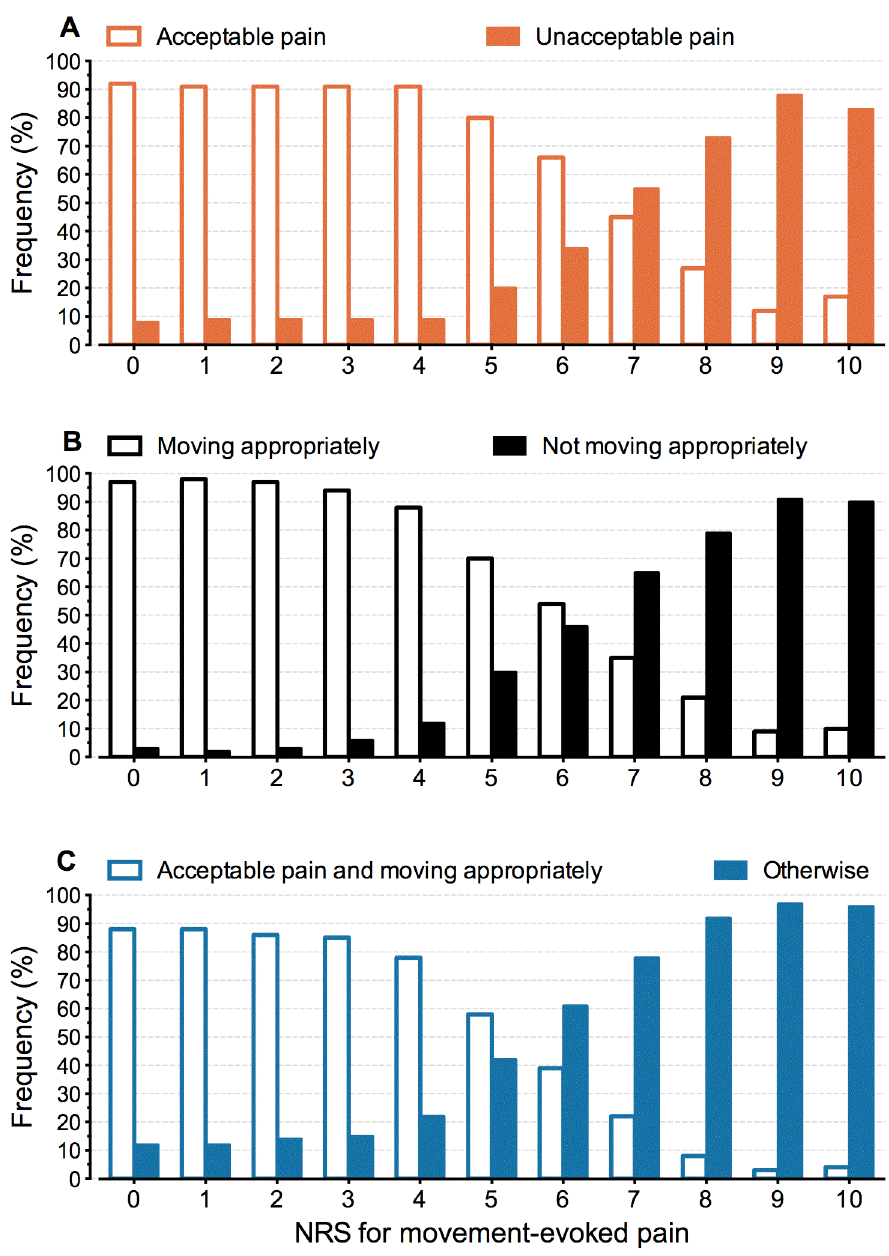
Fig 2. Relative frequencies for observations of patients’ opinion (A), nurses’ observation (B), and the measurecombining patient’s opinion and nurses’ observation (C) against NRS-MEP scores. The observations in all patients gatheredduringthe first three postoperative days were